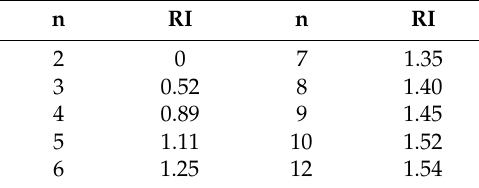
Table 2. Value of index RI